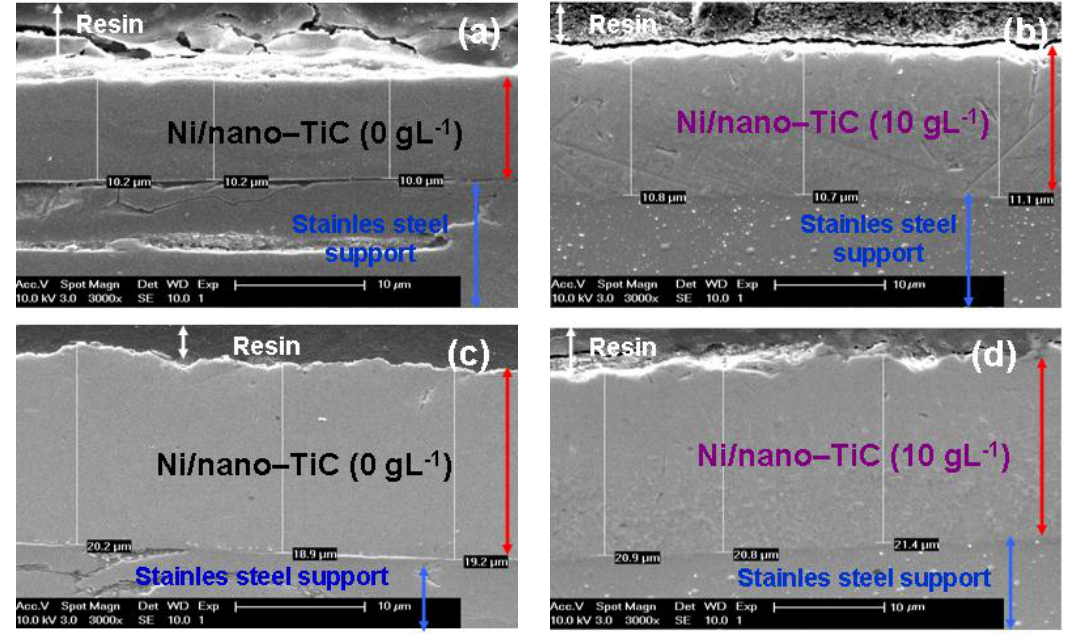
Figure 13. SEM micrographs of cross section for layer thickness measurement of pure Ni ( a , c ) and Ni/nano-TiC (10 g · L −1 ); ( b , d ) nanostructured composite layers obtained at a current density of 40 mA/cm 2 and a codeposition time of: 15 min ( a , b ); and 30 min ( c , d ).